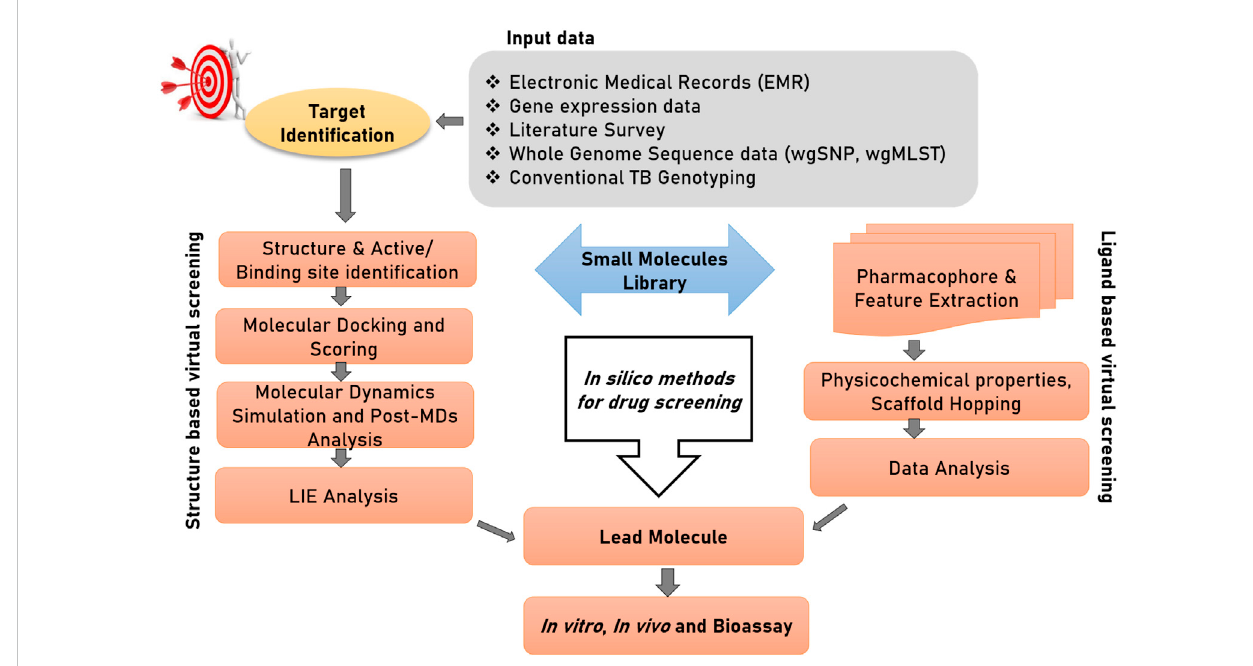
FIGURE 3 Structure-basedandligand-baseddrugdesigningpipeline.The fi rststepofdrugdiscoveryisproteintargetdenti fi cation,inwhichdisease-modifying targetproteinscouldbeidenti fi edthroughelectronicmedicalrecords(EMRs),geneexpressiondata,wholegenomesequencingdata;speci fi callywhole- genome singlenucleotide polymorphism (wgSNP) to categorize SNPs that distinguishisolatesin a genotypematched cluster, whole-genome multiocus sequence typing (wgMLST), and conventional TBgenotyping data which examine speci fi cregions in M. tuberculosis genome and distinguish strains based on gain or loss of segments of DNA sequence. Compound library preparation could be done through various databases and different virtual screening and pharmacophore modelling could be done to select a potential lead compound against target protein. Afterward to con fi rm their interactionsandconformational fl exibility,moleculardockingandMDscouldbeperformed.Finally,tocalculatebindingenergyofproteinwithligandand solvent, linear interaction energy can be done to produce a potent